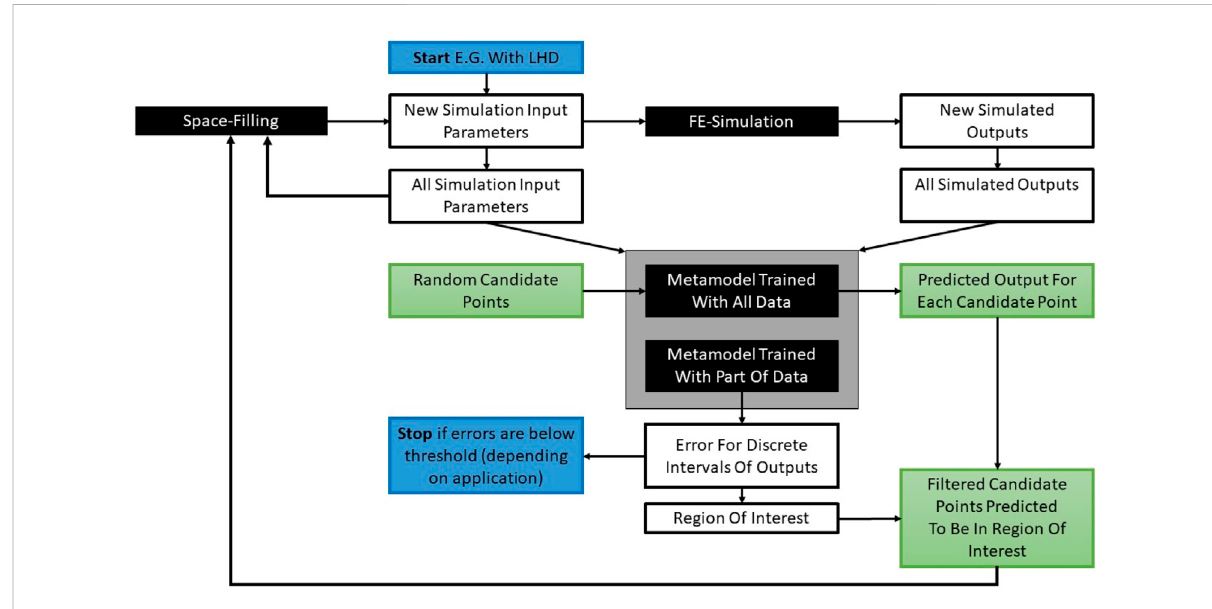
FIGURE 4 Basic principle of feedback loop combining DoE algorithm and